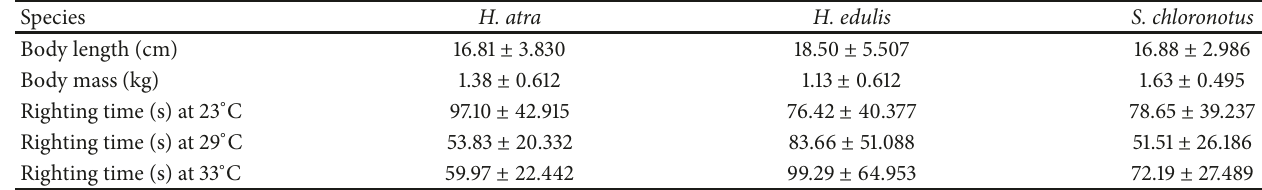
Table 1: Summary statistics for body length, body mass, and the righting times at the three experimental temperatures for the three species. Given are the means ± standard deviations.